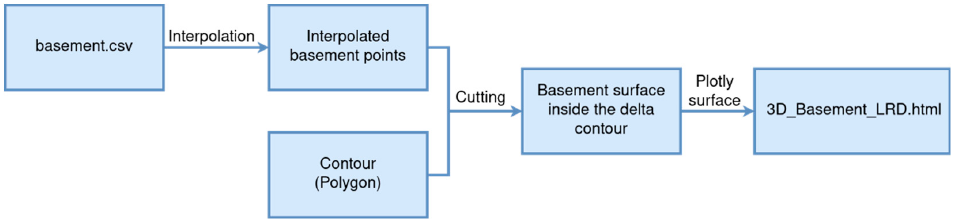
Figure 7. Flow diagram showing the 3D basement top surface mapping stage.